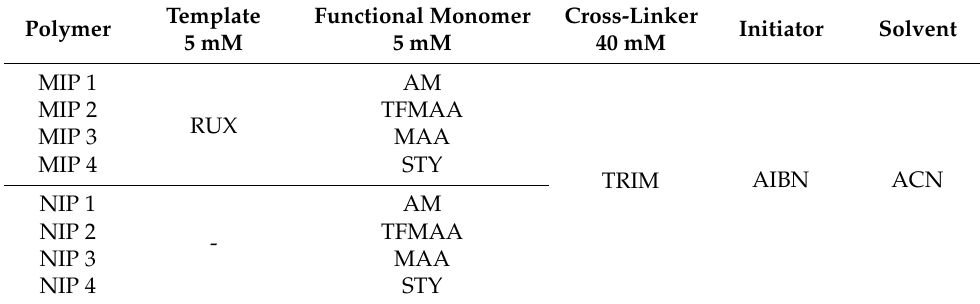
Table 2. Composition of the pre-polymerization